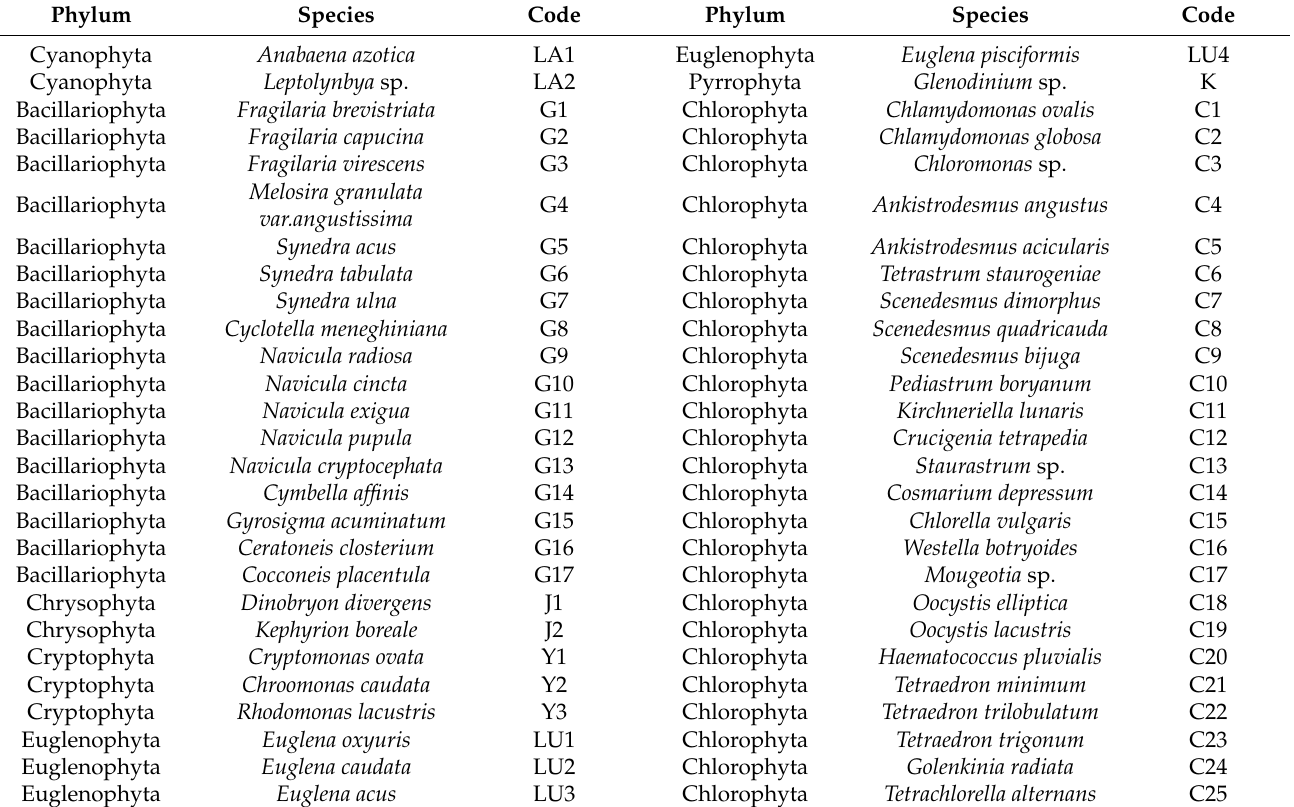
Table A1. List of phytoplankton with occurrence frequency ≥ 10% in spring, summer, and autumn in Zhalong